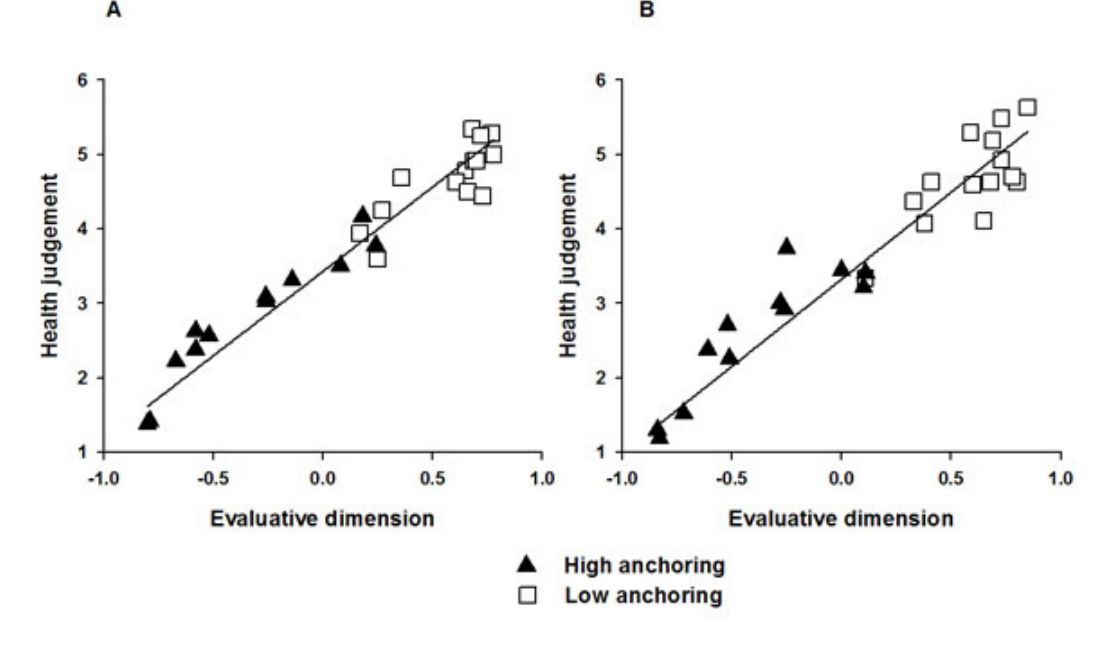
Fig. 5 . The relationship of coral health ratings and the evaluation dimension of the perceptual meanings provided by participants who had a working association with coral reefs (A) and those who did not